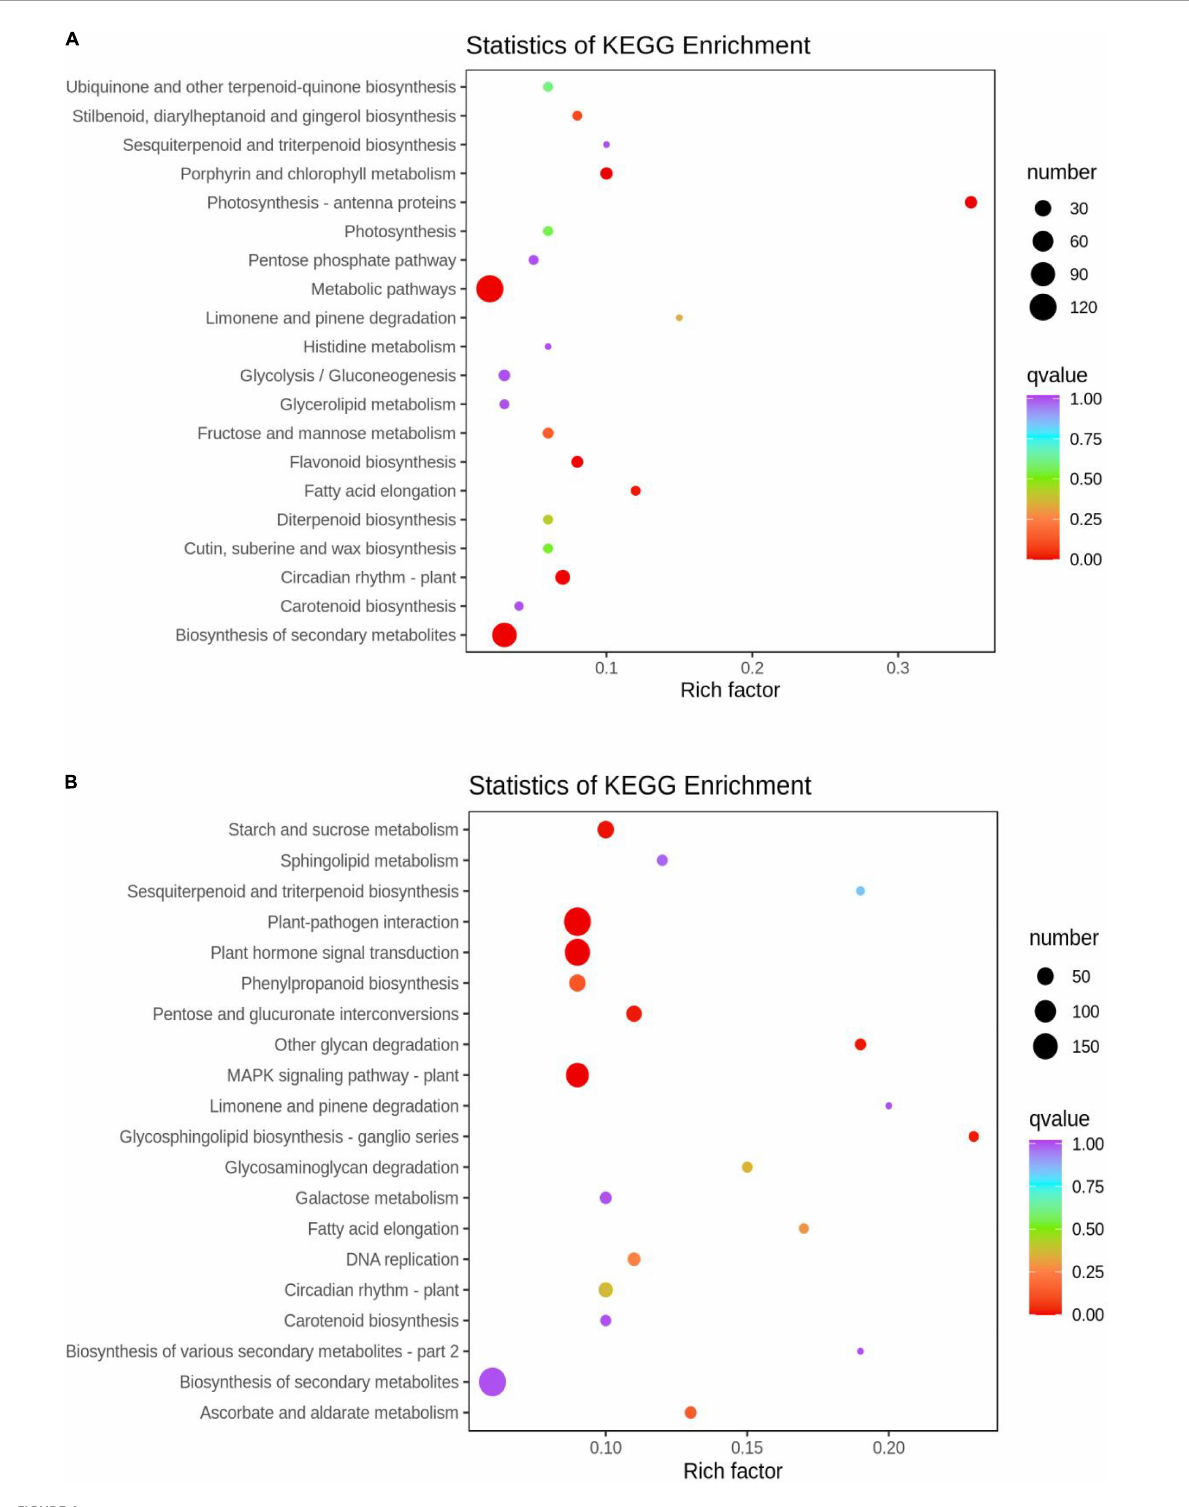
FIGURE4 KEGG enrichment scatter plot. The ordinate represents the KEGG pathway. The abscissa represents the Rich factor. The greater the Rich factor, the greater the degree of enrichment. The larger the dot, the higher the number of differential genes enriched by the pathway. The redder the color of the dots, the more significant the enrichment. (A) HN44 group; (B) HN65